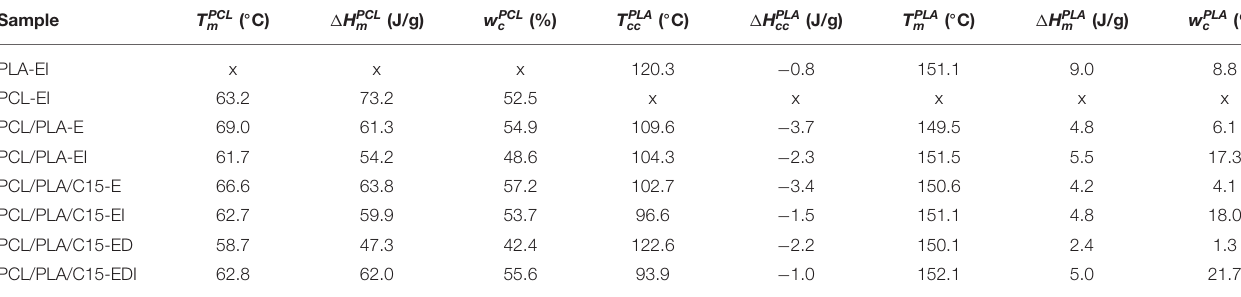
TABLE 2 | DSC results: melting points and crystallinities of PCL and PLA in all prepared samples. Sample